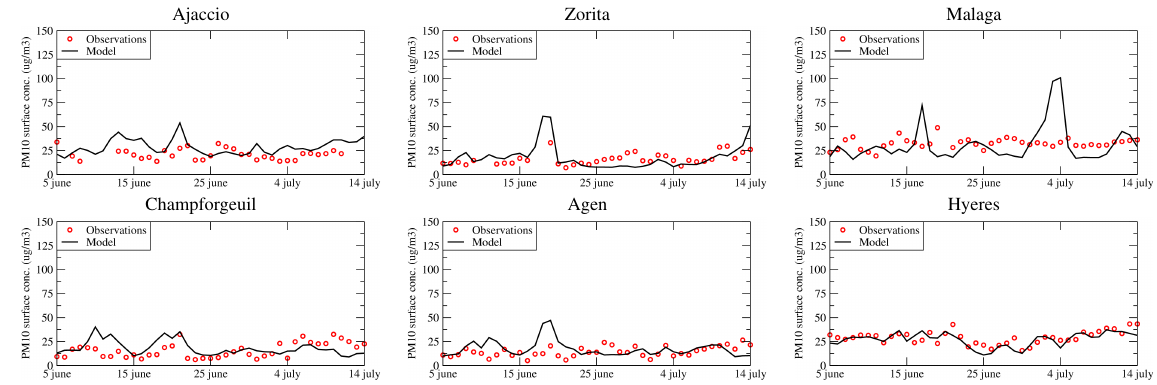
Figure 15. Time series of daily averaged PM 10 surface concentrations for some selected AirBase sites, continental and coastal stations.